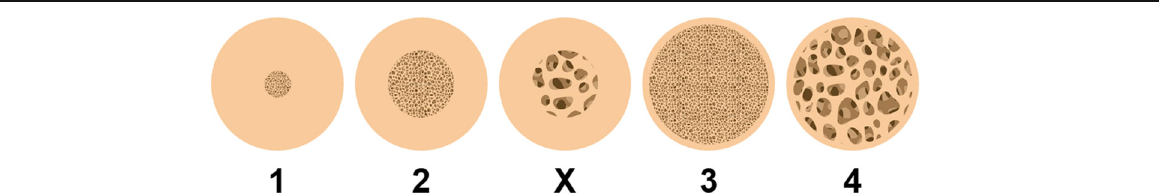
Fig. 3 One possible missing category (depicted as “ X ” ) would be a bone type with thick cortical layer and sparse trabecular bone, which would have intermediate characteristics and behavior between the types with thick (2) or thin (3) cortical